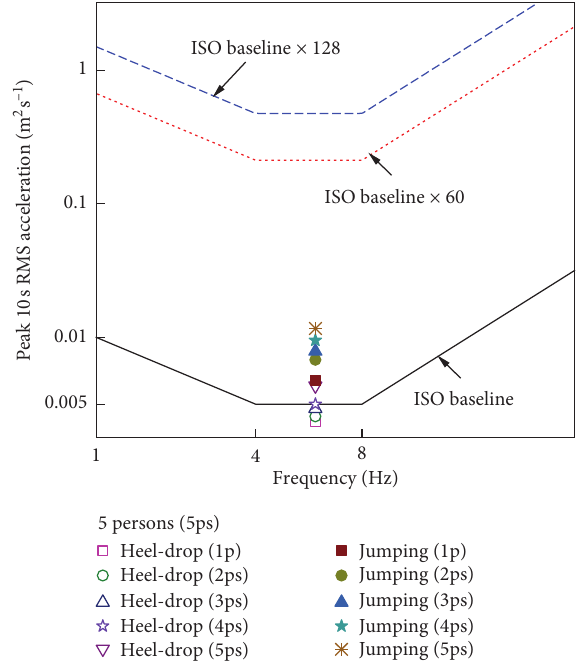
Figure 11: Vibration serviceability assessment by